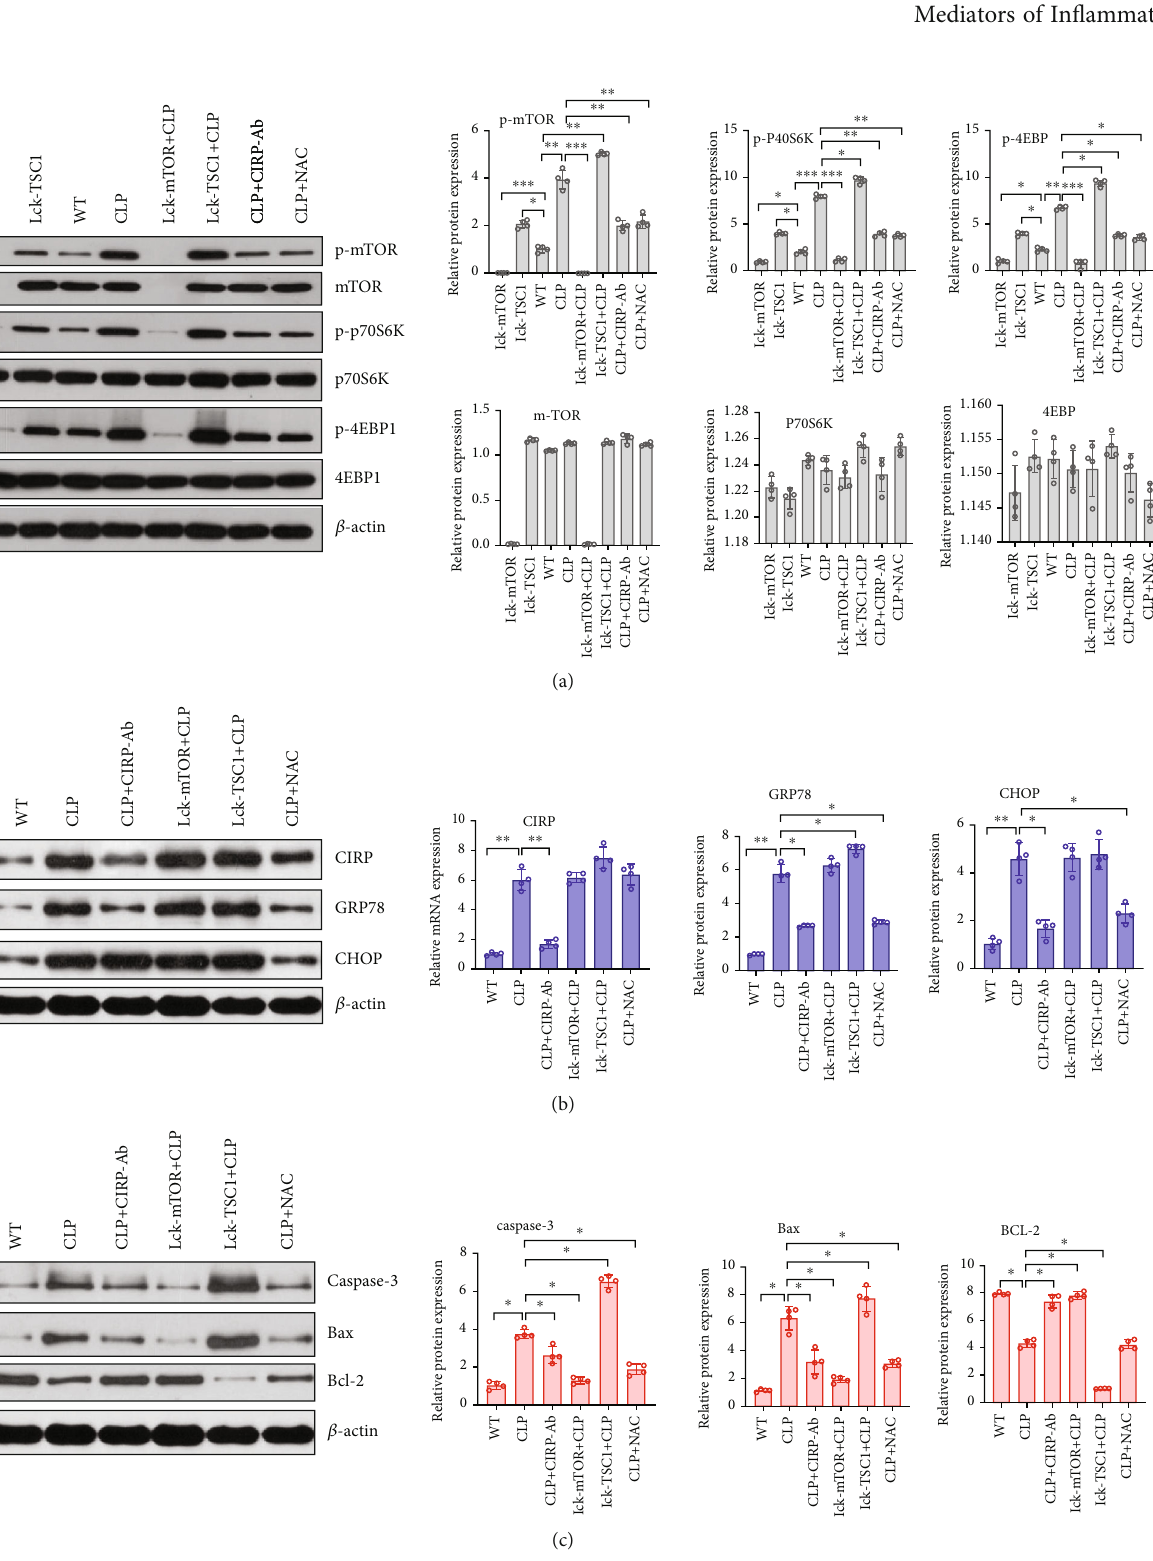
Figure 6: CD4 + T cells were assessed for the expression of mTOR pathway-associated proteins, ERS-associated proteins, and apoptosis- associated proteins in WT, LCK-mTOR, LCK-TSC1, CLP, CLP+CIRP-Ab, CLP+NAC, LCK-TSC1+CLP, and Lck-mTOR+CLP mouse groups. Data are mean ± SD . Number of mice per group = 4 (one-way ANOVA Tukey ’ s post hoc test). CD4 + T cells were puri fi ed from CIRP-Ab-treated mice, NAC-treated mice, TSC1 knockout mice, and mTOR mouse spleen lymphocytes. Total proteins were western blotted to identify the expression patterns of mTOR pathway proteins (P-mTOR, mTOR, p70s6k, p-p70s6k, P-4EBP, and 4EBP) (a); CIRP and ERS-associated proteins (GRP78 and CHOP) (b); and apoptosis-related proteins (caspase-3, Bax, and Bcl-2)